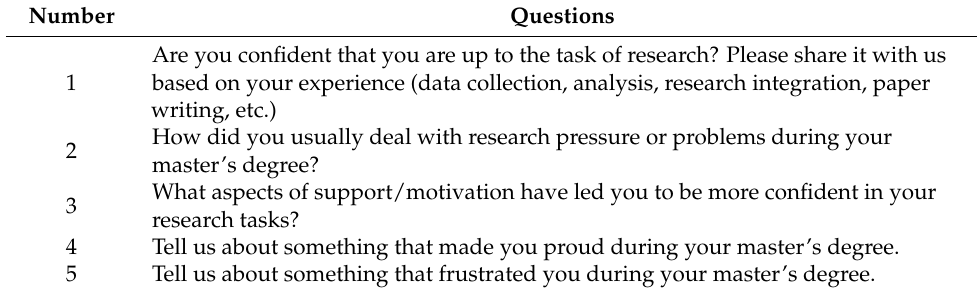
Table 2. Interview guide for nursing postgraduate students.